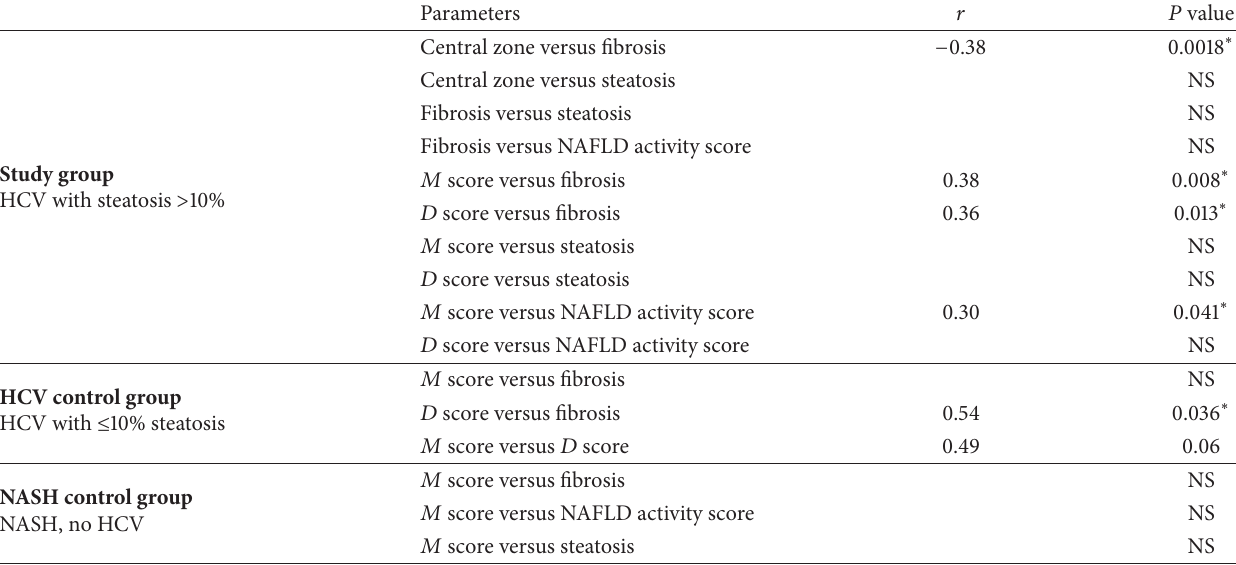
Table 3: Pearson’s correlation coefficient ( 𝑟 ) and 𝑃 values for histologic parameters. NASH: nonalcoholic steatohepatitis; NS: not statistically significant ( 𝑃 ≥ 0.05 ); ∗ 𝑃 < 0.05 : statistically significant; NAFLD: nonalcoholic fatty liver disease [36]; 𝑀 score and 𝐷 score: see Section 2.4 for